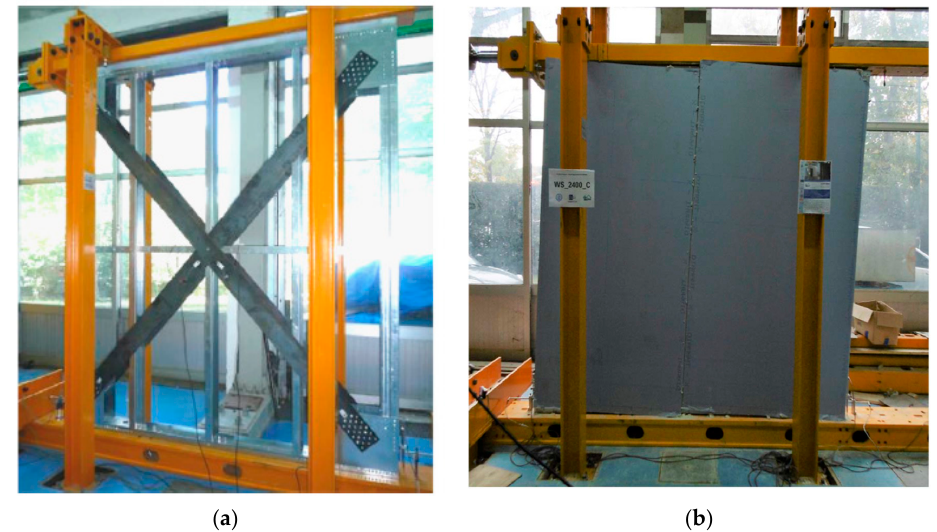
Figure 7. Pictures of the tested specimens. ( a ) CFS strap-braced walls [5]; ( b ) CFS gypsum sheathed shear walls [6].